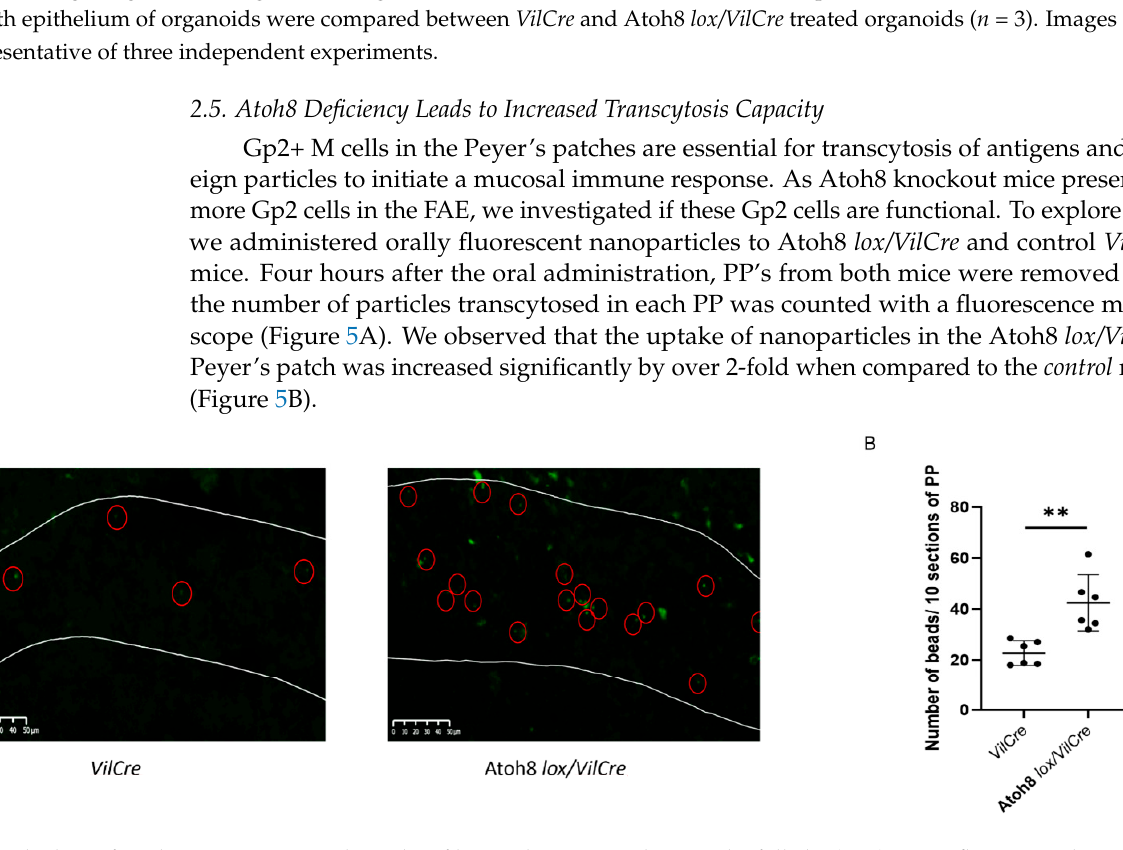
Figure 5. The loss of Atoh8 causes increased uptake of luminal nanoparticles into the follicle. ( A , B ) Green fluorescent latex beads (200 nm diameter) were orally administered to VilCre or Atoh8 lox/VilCre mice. 3 h later, PPs were collected from the jejunum. Ten consecutive cryosections of each PPs were examined by fluorescence microscopy, and the number of particles was counted manually. ( A ) Representative images of cryosections. White lines indicate FAE. Red circles indicate fluorescent particles. Bars, 50 µ m. ( B ) Quantification of particles in PPs. **, p < 0.01; Student’s t -test; n = 3 per